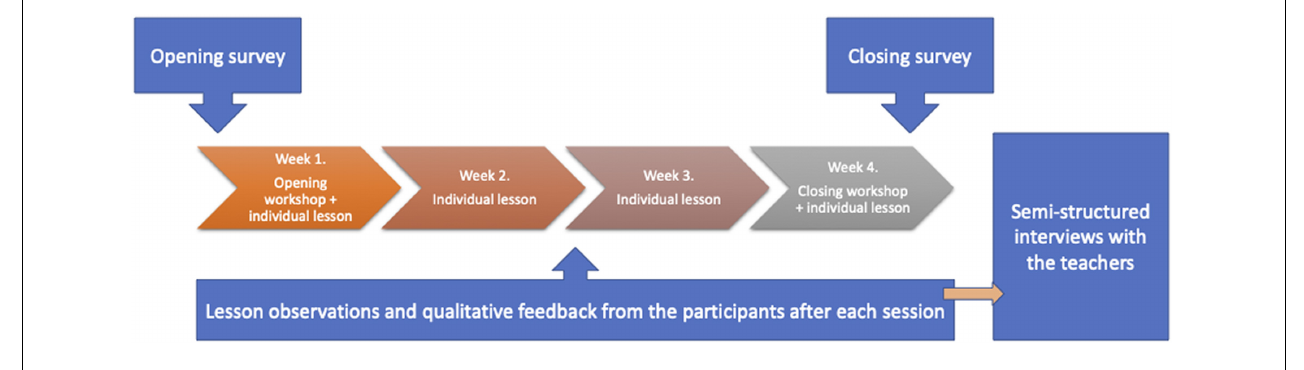
FIGURE 1 | The process of the data